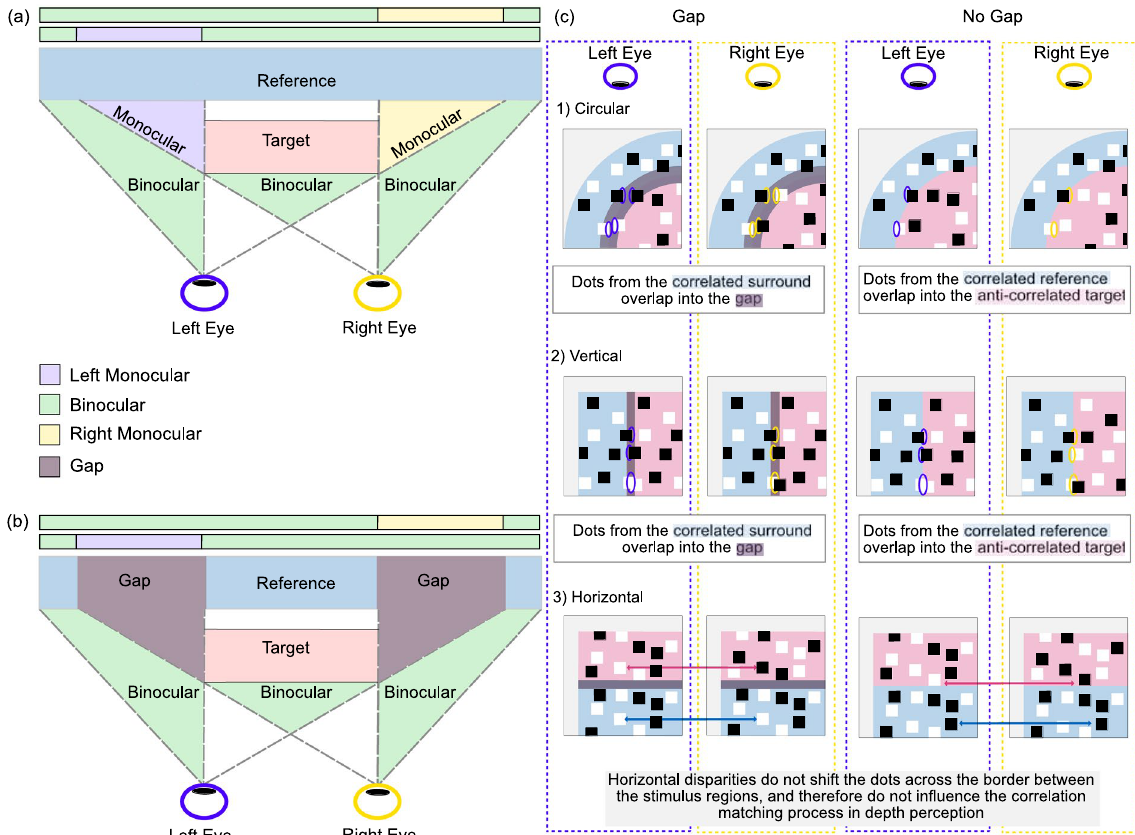
Figure 5. ( a ) Da Vinci stereopsis: when an object (Target) occludes different parts of a background (Reference) from each eye’s perspective, there is a difference between the images in the left and right eyes 50 . However, ( b ) Including a gap between the Target and the Reference, reduces or eliminates this monocular occlusion. ( c ) A schematic representation of the process of Da Vinci stereopsis for different types of edges. The different image for each eye can contain matched (correlated) and unmatched (uncorrelated) information. With the exception of the horizontal condition (3), stimuli without a gap between the target and the reference (such as 1 and 2) create a potential area of overlap between correlated and uncorrelated